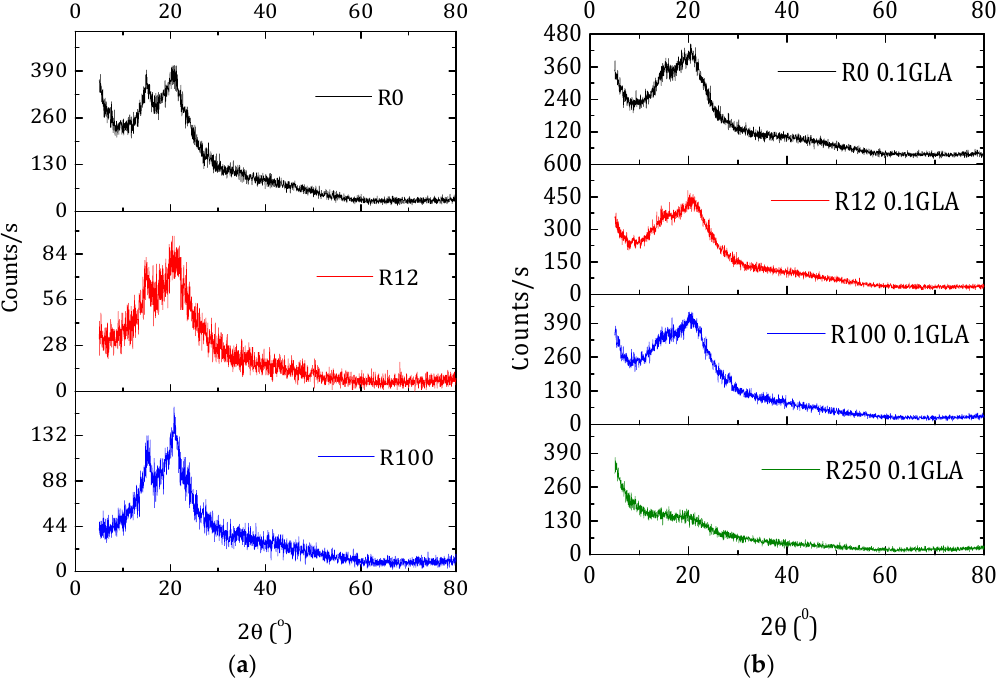
Figure 7. X-ray diffraction patterns of the membranes prepared with non-irradiated and irradiated chitosan at different doses: ( a ) without GLA and ( b ) with 0.1 wt % GLA in the chitosan solution.